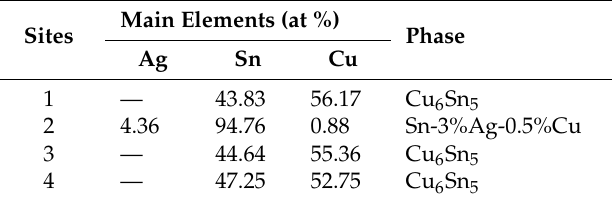
Table 1. The EDS